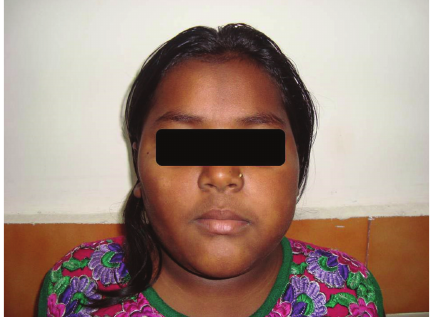
Figure 1: Extraoral photograph showing asymmetry.